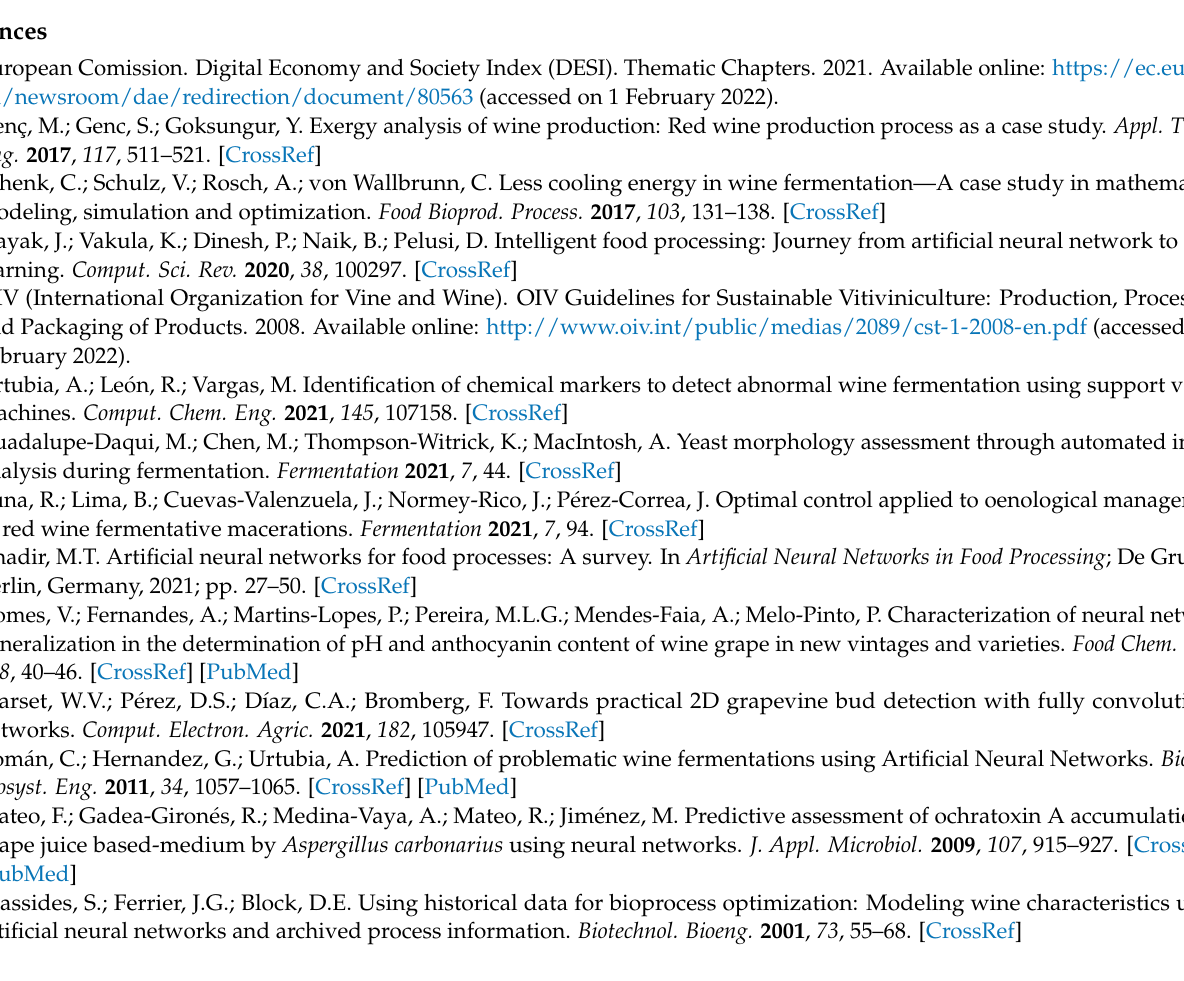
Figure A4. Training and testing